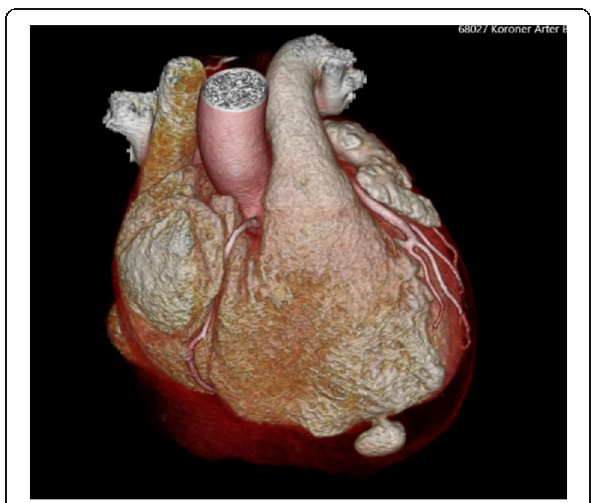
Fig. 2 The 3D volume rendering CT image shows a small outpouching from the right ventricle apex into the pericardial space, connected through a small neck to the